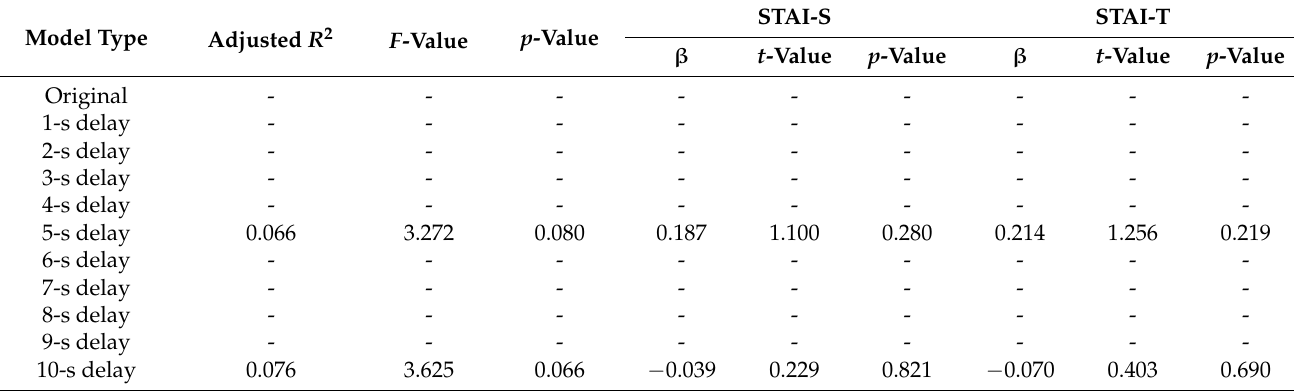
Table 4. Results from multiple regression analyses for the no temporal pressure conditions ( n = 33) concerning the associations between participants’ model fitting coefficients and their self-reported anxiety